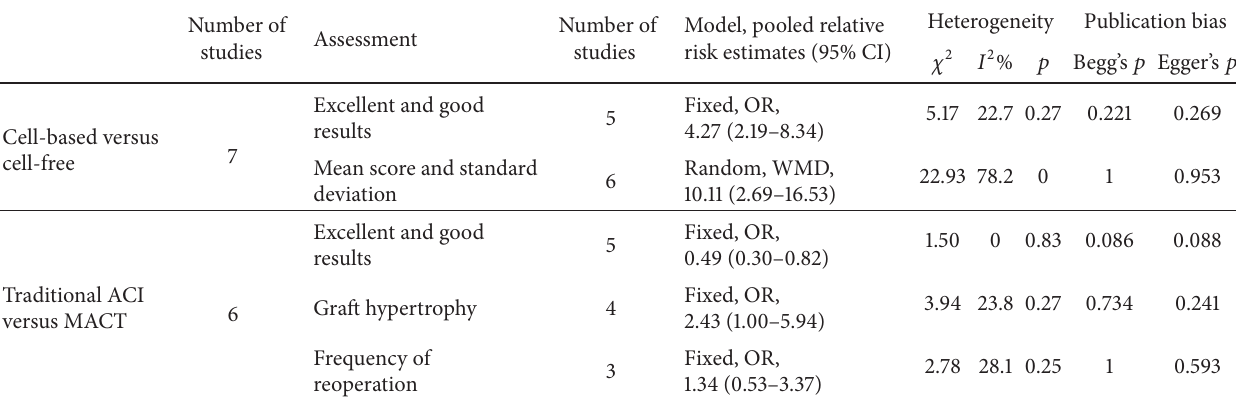
Table 7: Results of meta-analyses in our